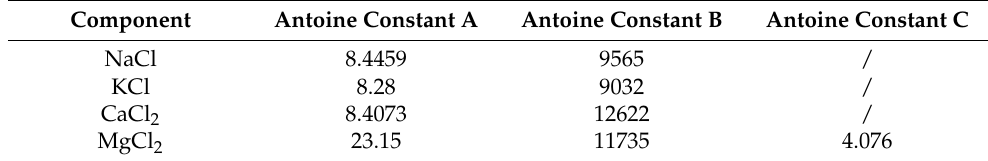
Table 8. Antoine constants for the pure salts.